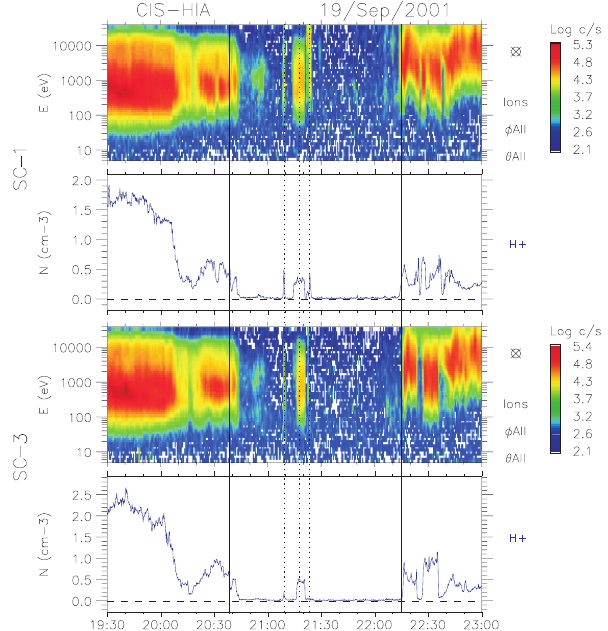
Fig. 2. H + ion densities and energy flux spectrograms from C1 and C3. As can be seen, the spacecraft are located inside the plasma sheet until the substorm onset at about 20:39UT (first solid vertical line). Before substorm onset, Cluster detected high-energy ions and a high particle density. During the substorm, i.e., until the beginning of the recovery phase at about 22:15UT (second solid vertical line), no high-energy ions were detected and the particle density drops down, indicating Cluster being in the lobe. Several intensifications of the energy flux and enhancements of the plasma density are due to short excursions back into the plasma sheet or PSBL. As can be seen, Cluster s/c 3 remains in the lobe for the first and third excursion of s/c 1 (dotted